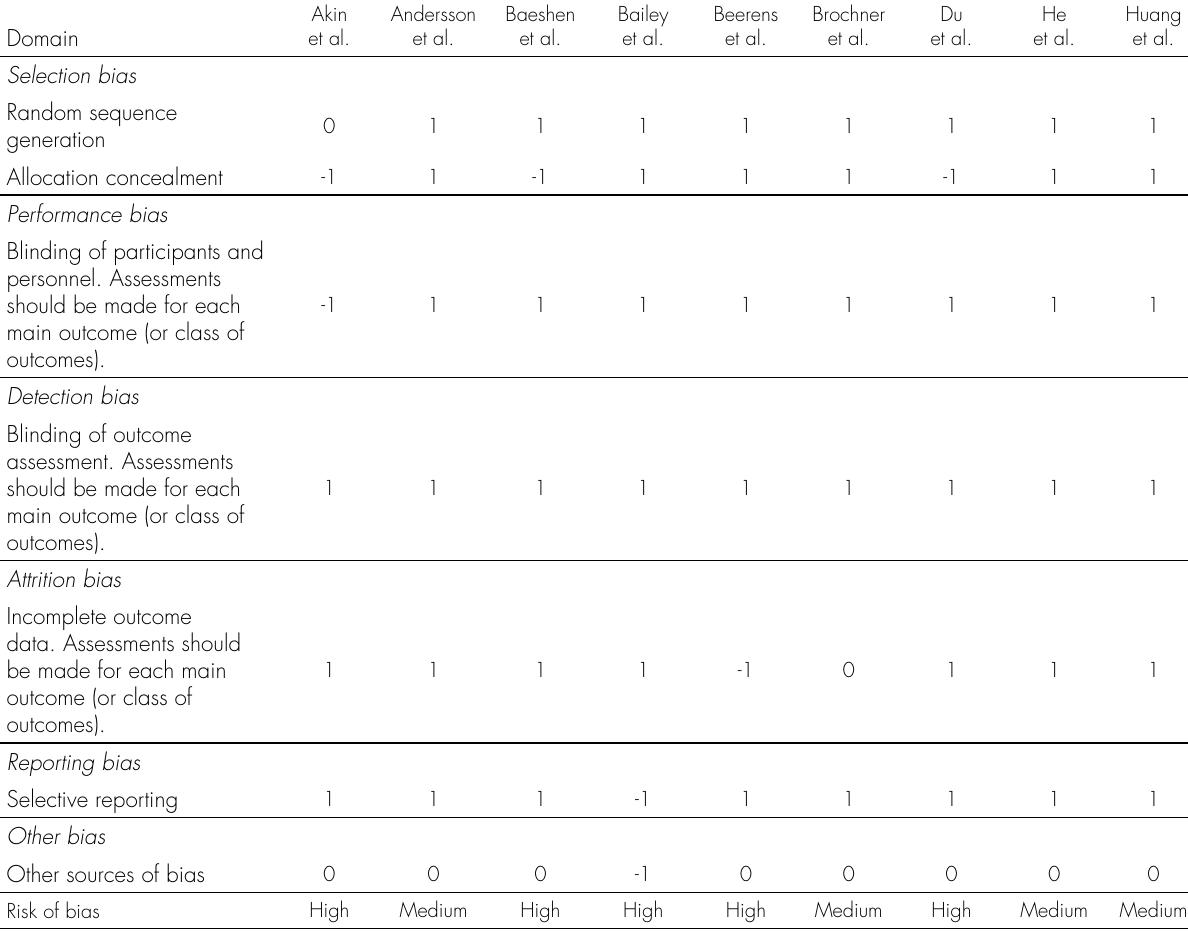
Table I. Bias risk assessment of included